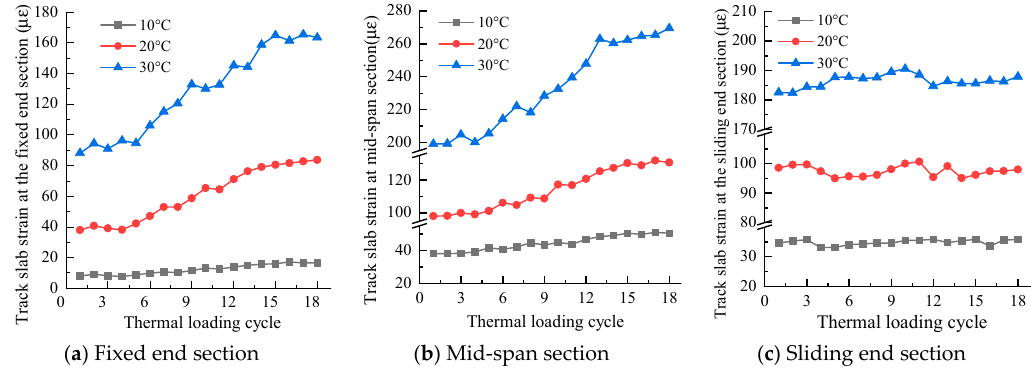
Figure 12. Variation of the track slab strain with the thermal loading cycle.